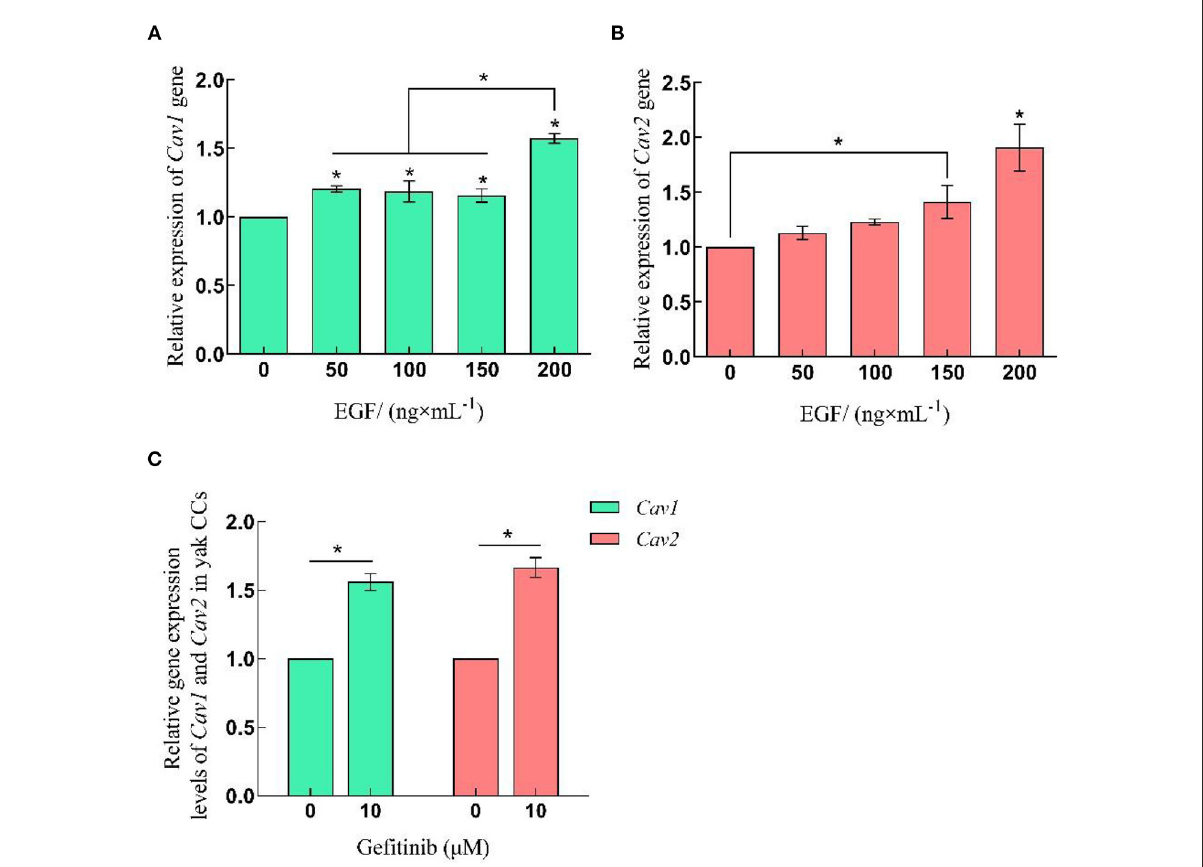
FIGURE5 Relative expression levels of Cav1 and Cav2 gene in yak CCs treated with different concentrations of EGF and the optimal concentration of gefitinib (EGFR inhibitor). (A, B) Relative mRNA expression levels of Cav1 and Cav2 in yak CCs (EGF group). (C) Relative mRNA expression levels of Cav1 and Cav2 in yak CCs (Gefitinib group). *on the bars indicates values that differ significantly (* P < 0.05).